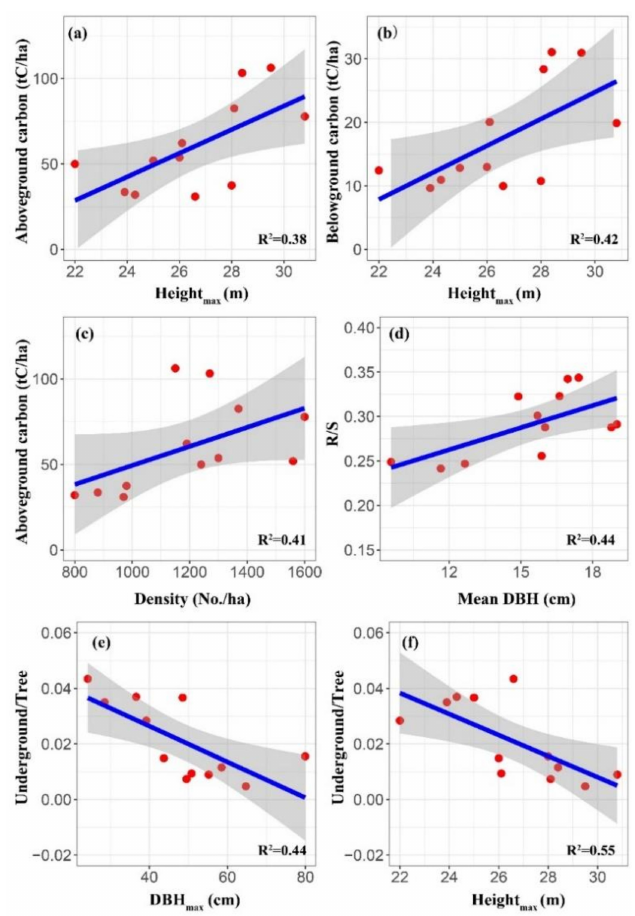
Figure 3. Relationship of carbon storage and allocation pattern with stand factors. ( a , c ) aboveground carbon; ( b ) belowground carbon; ( d ) R / S ratio; and ( e , f ) Understory / Tree